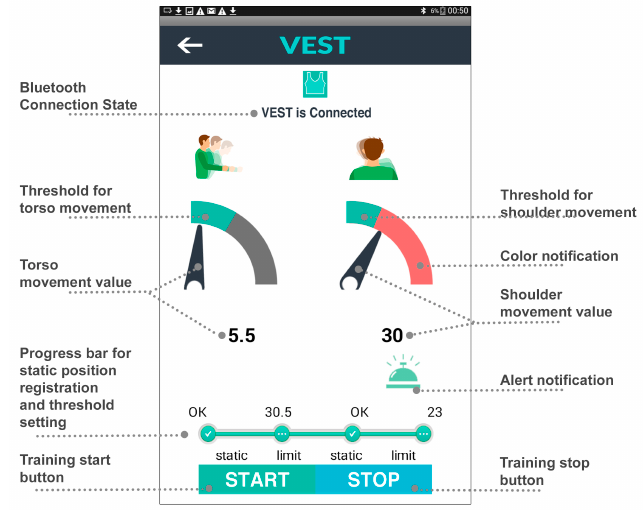
Figure 8. Interface Design.